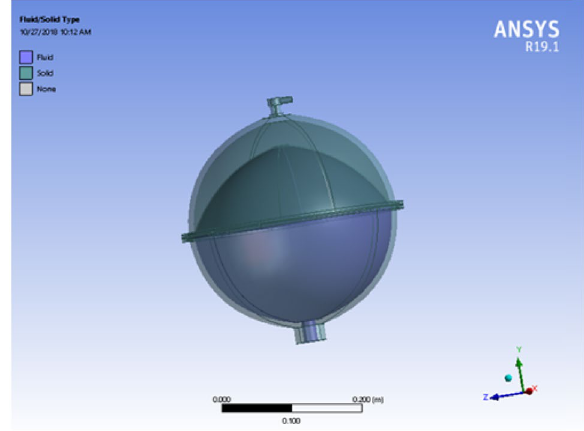
Fig. 26 The geometry of diaphragm tank in 100% volume ratio in ANSYS workbench